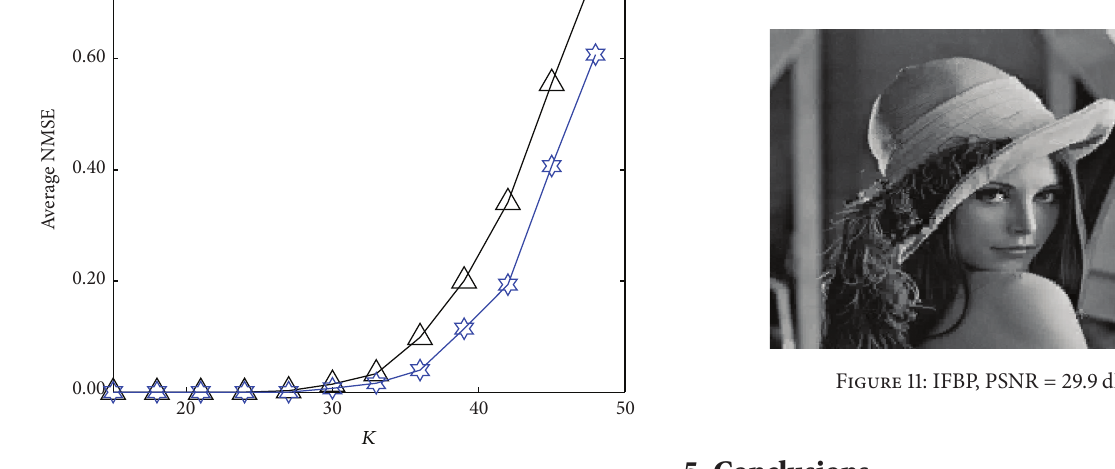
Figure 10: FBP ( 𝛼 = 10 , 𝛽 = 9 ), PSNR = 28.6 dB.